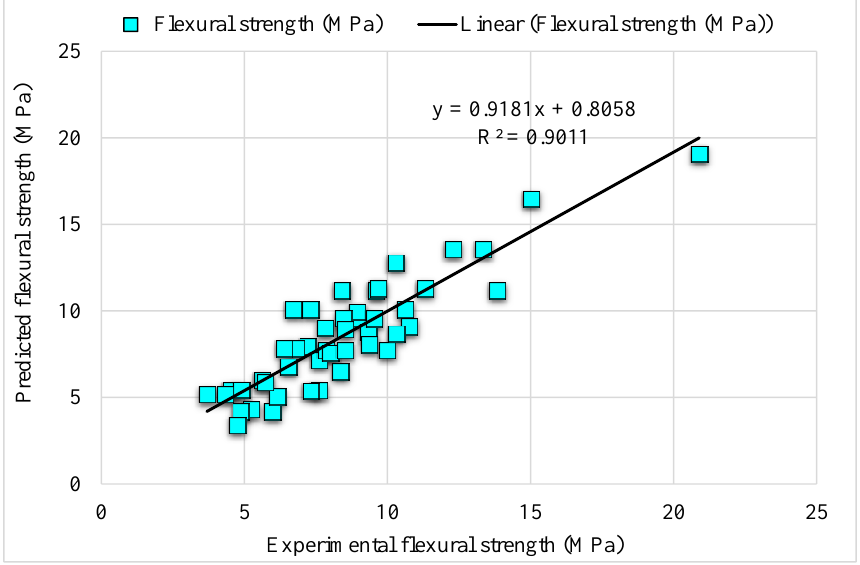
Figure 4. Experimental and AdaBoost predicted results.